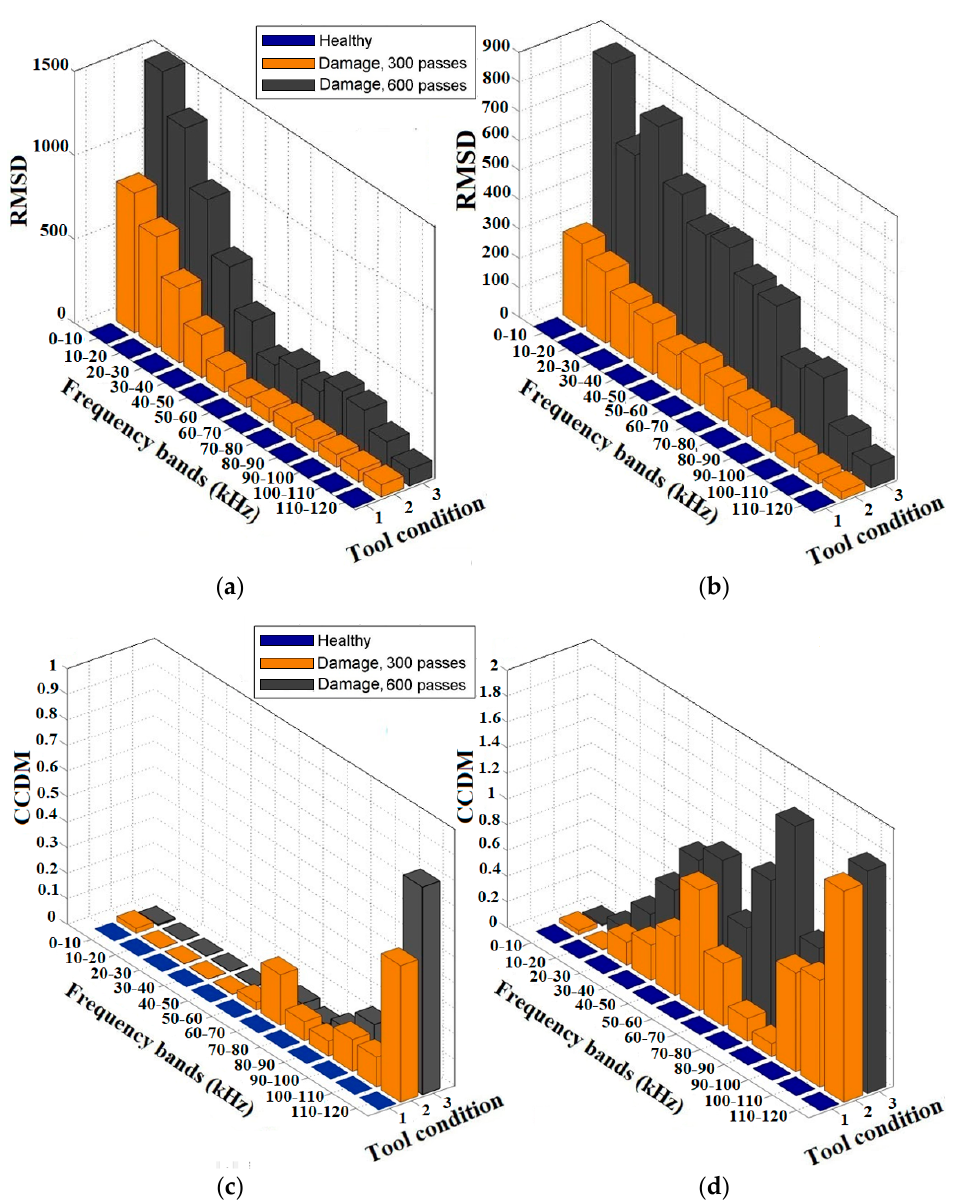
Figure 6. Damage indices results of the CVD diamond-dressing tool: ( a ) RMSD of PZT1; ( b ) RMSD of PZT2; ( c ) CCDM of PZT1; and ( d ) CCDM of PZT2.